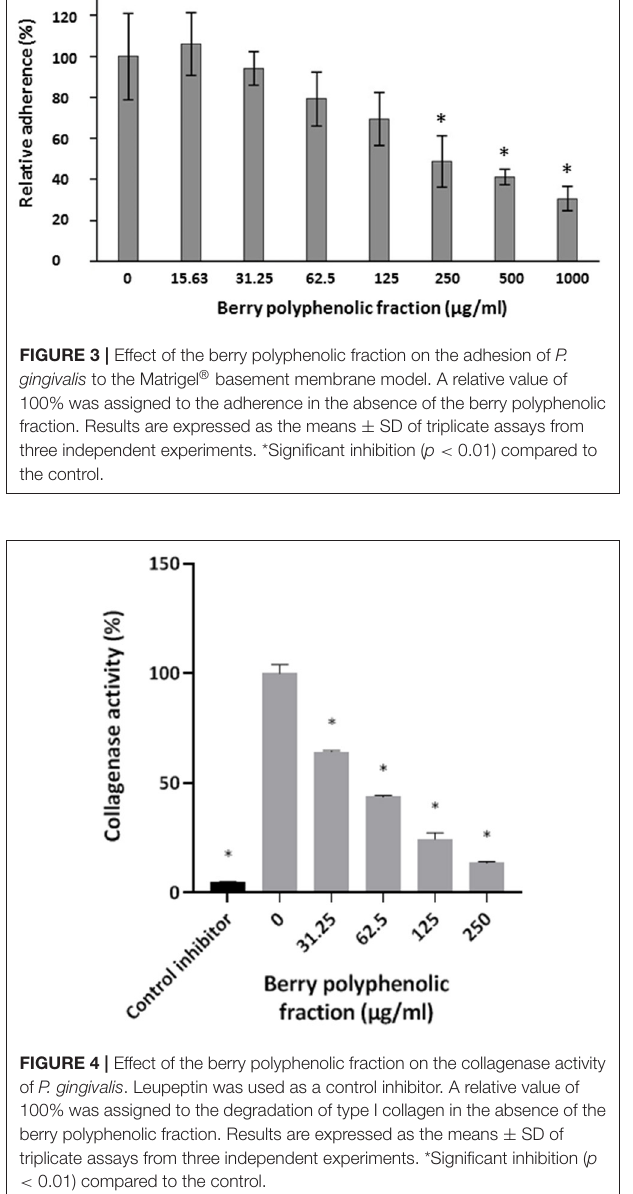
nm/Em: 420 nm) using a Synergy 2 microplate reader